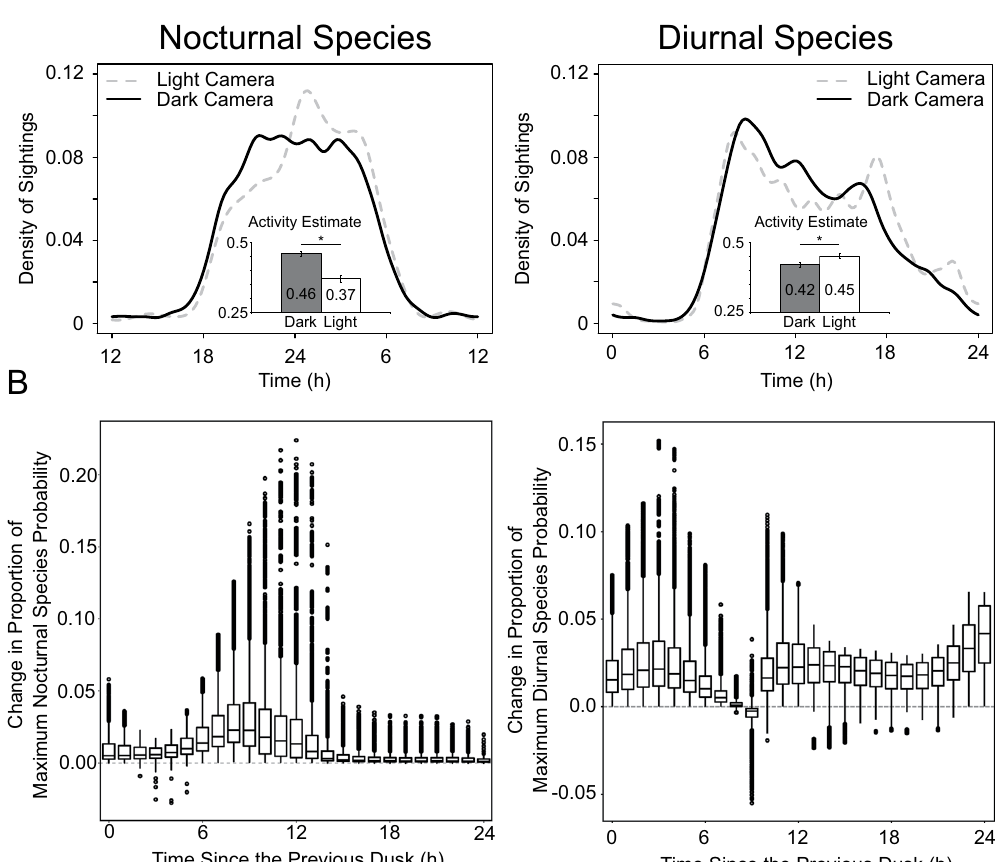
Figure 3. Populations of mammalian urban wildlife show significant changes in activity based on the level of light in their local environment. Daily activity profiles for nocturnal and diurnal mammals derived from tagged camera trap observations plotted based on local time ( A ). Activity profiles in light locations (locations with illumination > 6 lux) are represented as a dashed grey line while dark locations are represented as a solid black line. Significant differences were found between light and dark camera locations for both nocturnal and diurnal species. Panel A inset bar graphs represent overall activity estimates derived from the camera trap data. Inset values are represented as the mean ± SEM. Significant differences (p < 0.05; represented by an asterisk) were found between light and dark activity estimated for both groups of species. Logistic regression models ( B ) were used to control for temporal patterns of human activity and urbanization and show similar patterns to the raw density sightings in Panel A. ( B ) Simulates the predicted probability of observing nocturnal and diurnal species, sets each camera trap to light and then to dark, divides these values by the maximum probability for each condition, and then subtracts the value for simulated light cameras from simulated dark cameras. Horizontal lines in each box represent median values and the top and bottom of each box represent the 75th and 25th percent of each value. Single dots are values beyond 1.5X the interquartile range. The distribution of the boxplots highlights periods when species’ activity around cameras is expected to be most different between dark and light